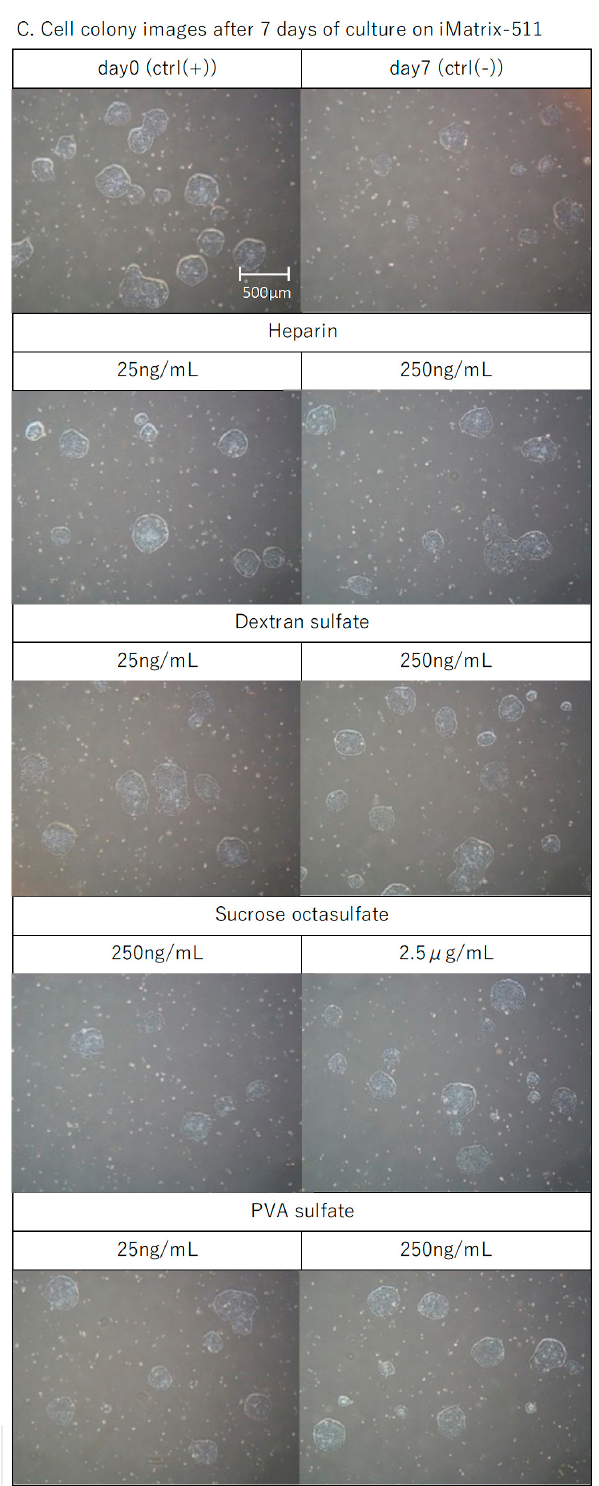
Figure 6. Effects of sulfated materials and heating of cell culture media on iPSC proliferation on Matrigel ( A ) or iMatrix-511 ( B ). The fold-changes in cell proliferation are shown. Differences between the cell numbers of test and negative controls were considered significant at * p < 0.05. Cell colony images after 7 days of culture on iMatrix-511 are shown ( C ). Microscopy images and colony counts were obtained using the Keyence BZ-X710 fluorescence microscope and its BZ-X Analyzer software (Osaka,